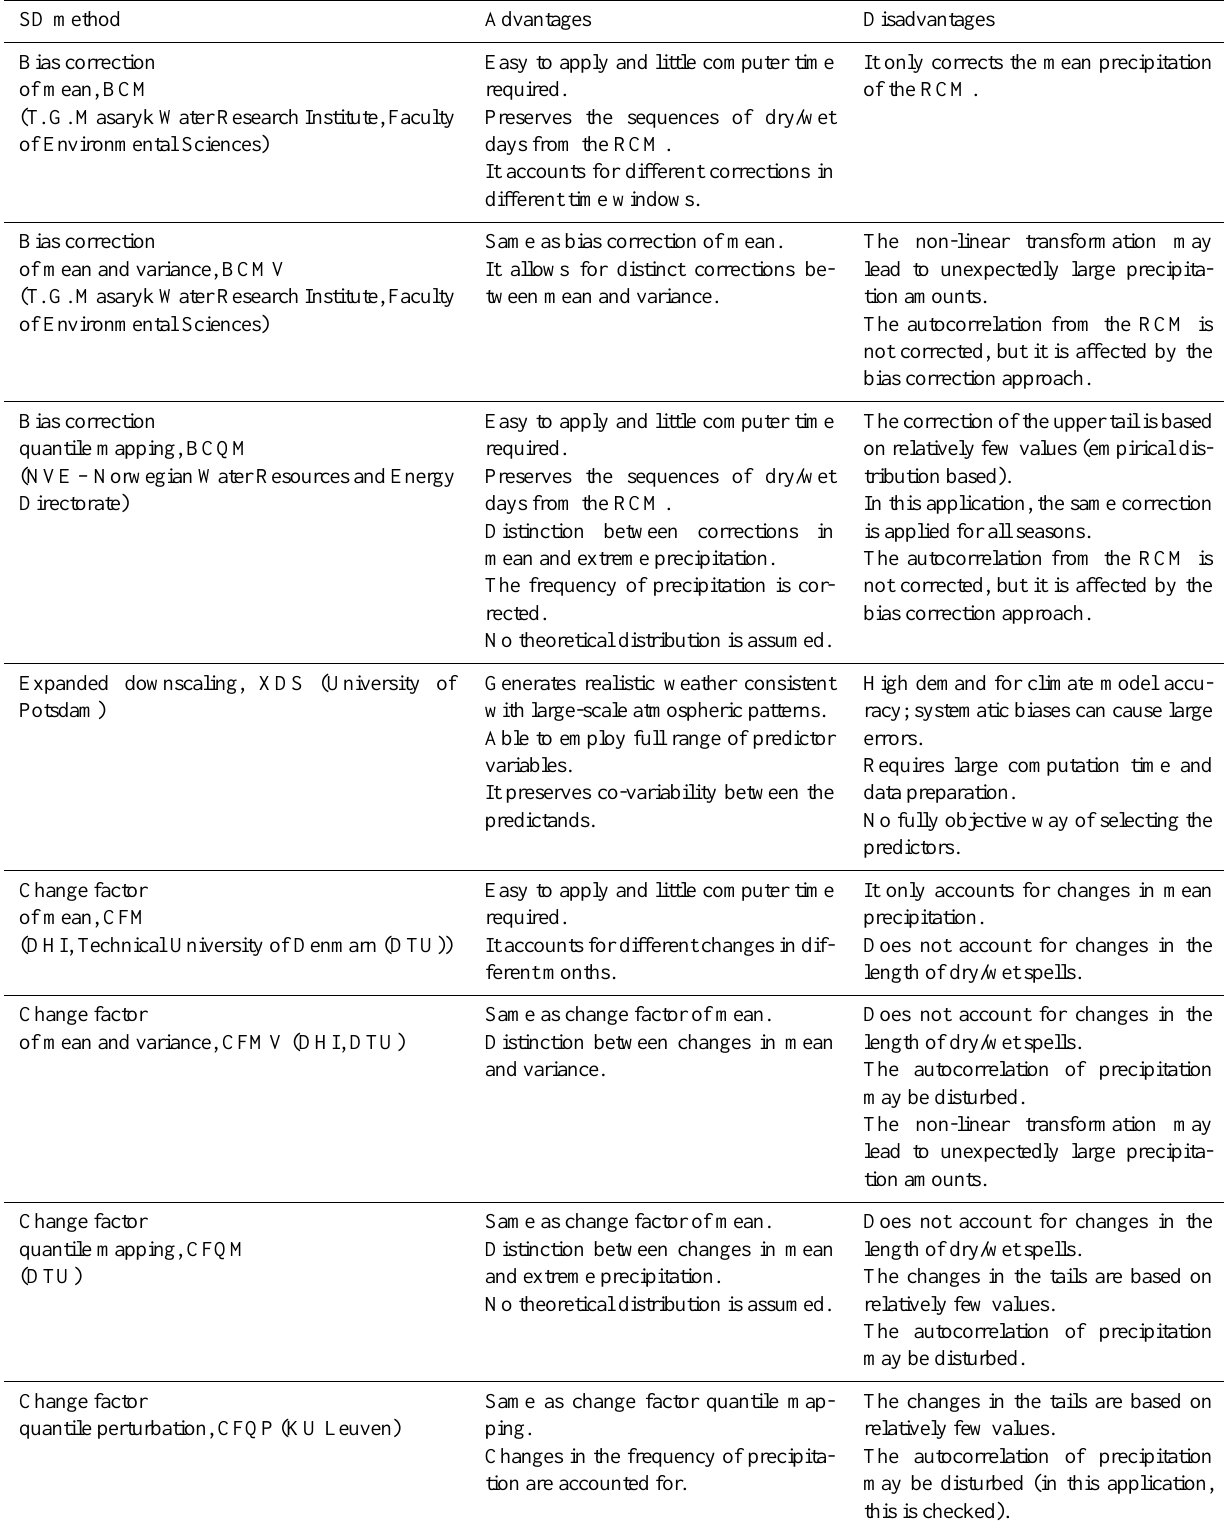
Table 3. Summary of the advantages and disadvantages of each statistical downscaling method. The name of the institution that undertook the downscaling work in this study is included in the first column. The advantages and/or disadvantages which are specific to the way the methods were applied in this application are